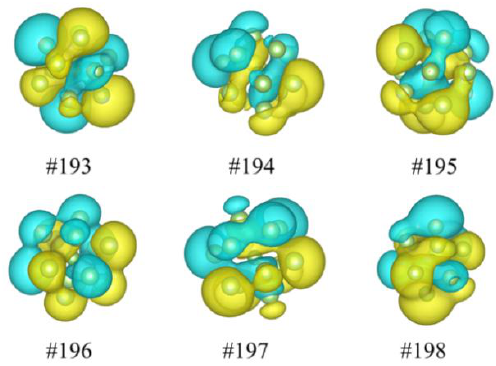
Figure 7. Wave functions of the hybridized F 3 P 3 superatomic-like orbitals of superatom-like As@Ga 12 cluster (the interatomic As–Ga bond distance is 2.547 Å). The superatomic-like wave functions are described in #193, #194, #195, #196, #197, and #198 superatomic-like orbitals, respectively.